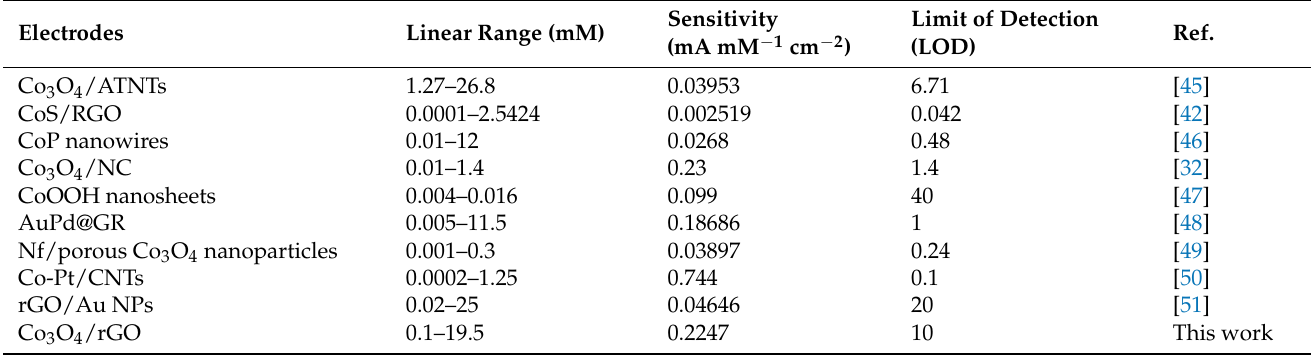
Figure 6. ( a ) Amperometric response of the Co 3 O 4 /rGO-modified electrode polarized at − 0.60 V in N 2 -saturated 0.1 M PBS solution with the subsequent addition of H 2 O 2 (Inset: responses to lower additions of H 2 O 2 ); ( b ) the corresponding calibration curve. Table 1. Comparison of the analytical performance of Co 3 O 4 /rGO-modified electrodes with previ- ously reported non-enzymatic H 2 O 2